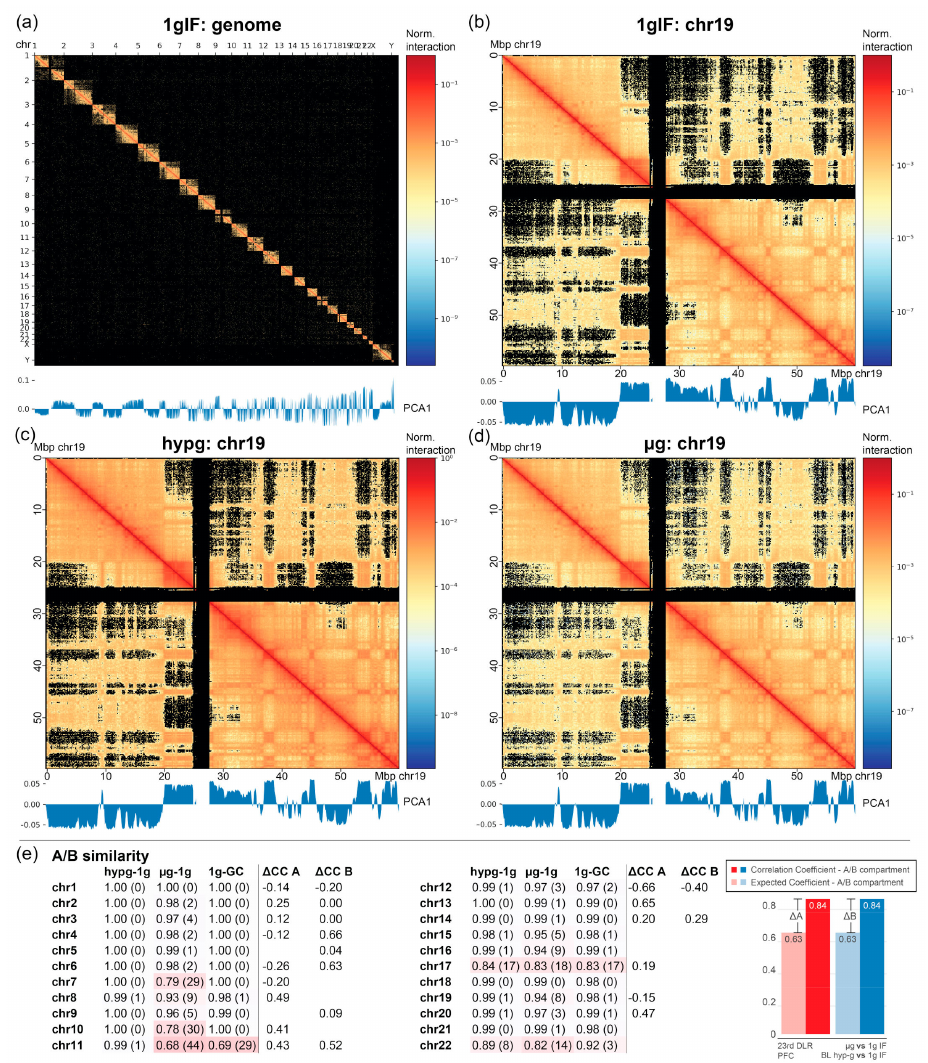
Figure 6. Chromosome conformation capture in altered gravity. ( a ) Interaction map of the en- tire human genome of Jurkat human immune cells during the 4th Swiss PFC. Chromosomes and chromosome compartments appear as rectangles. Pearson interaction scores are given. The A/B compartment eigenvector score as a measure of eu-/heterochromatin compartmentalization is given below. ( b – d ) Interaction map of chromosome 19 and A/B compartmentalization for the three flight phases (i.e., 1 × g inflight reference, hypergravity, and microgravity). No larger structural change of A/B compartments could be identified. ( e ) Quantification of the A/B similarity among different flight conditions. Given is the medium and the first standard deviation of the Pearson correlation coefficient of the A/B calling tracks between the samples of two flight conditions. Hypg-1g represents the in-flight changes between normal gravity and hypergravity, µ g-1g represents the effects of micro- gravity, and 1g-GC indicates the flight vs. ground reference control. Additionally, the differences in actual and expected correlation coefficients for the two 23rd DLR PFC transcriptomics samples are given for the A and B compartment subsets per chromosome if applicable (compare Figure 4 subset testing). The score is explained in the diagram on the